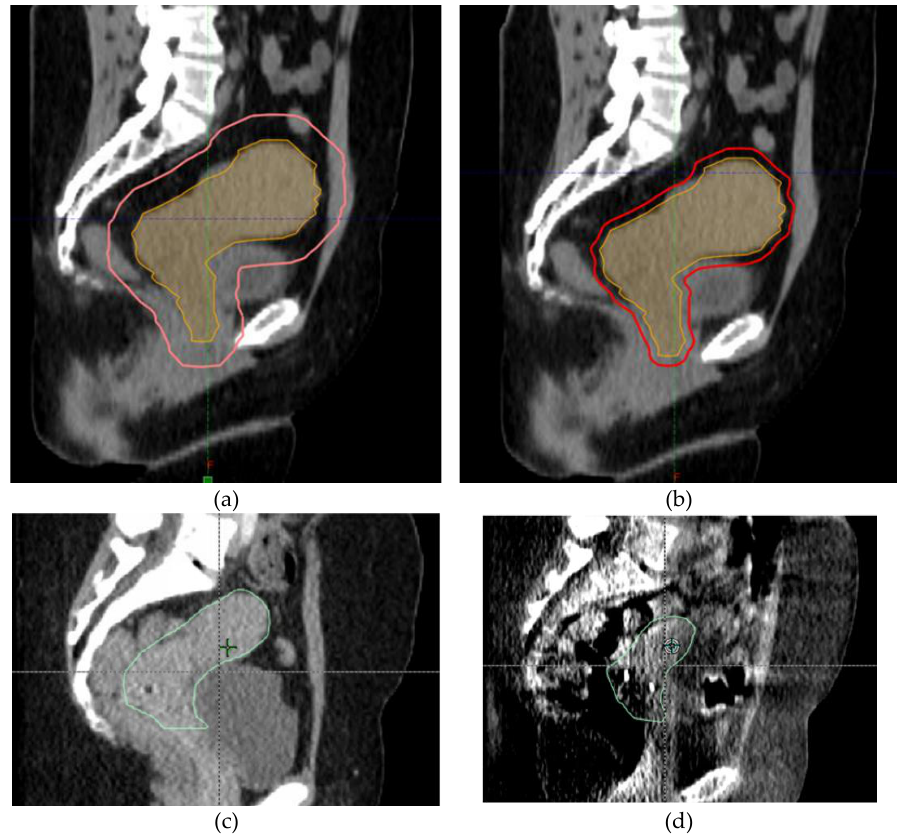
Figure 3. Potential benefits of ART. ( a , b ) show the decrease in CTV to PTV margins with daily adap- tive radiation. The uterocervix CTV is in orange and the PTV is in red; ( c , d ) show the decrease in target size between the first fraction and last fraction. The uterocervix CTV is in green.